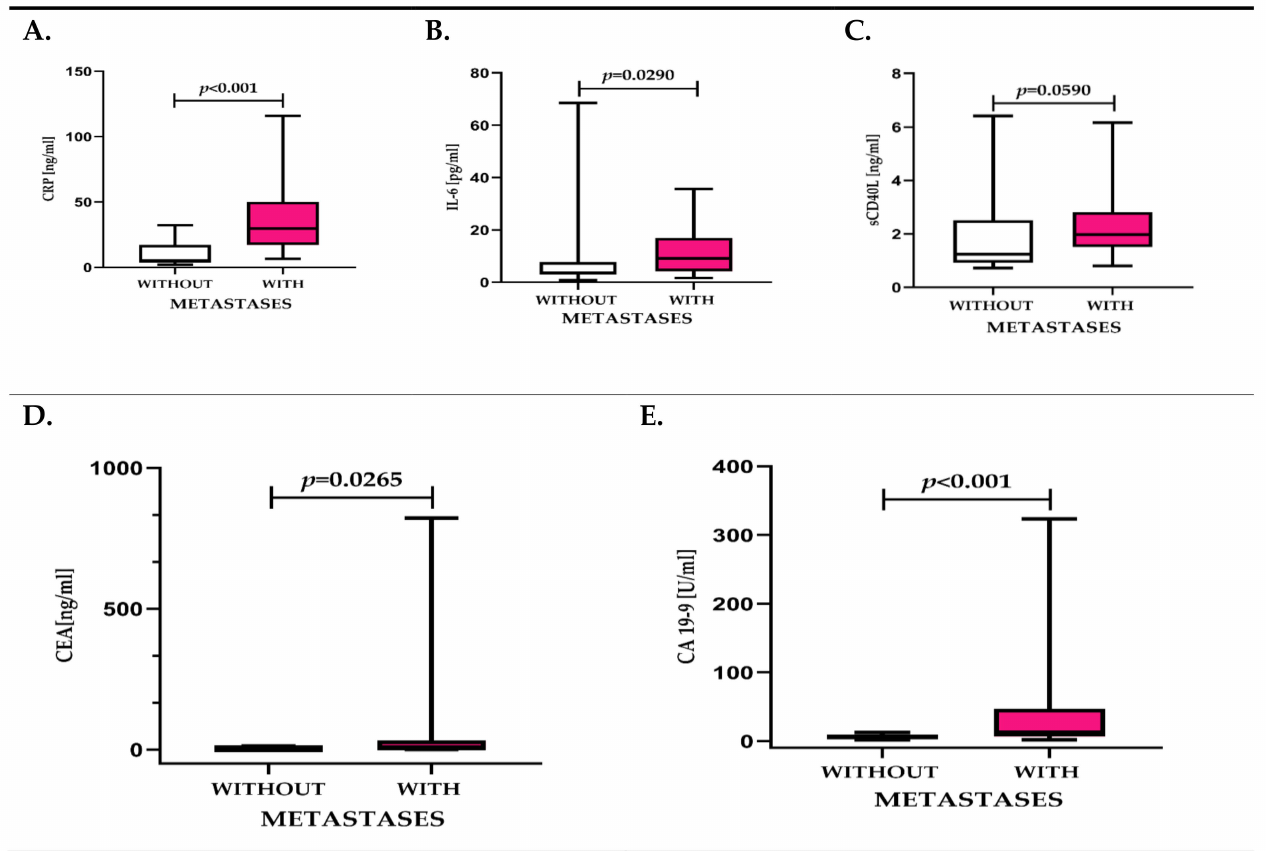
Figure 3. ( A – E ). Concentration of inflammatory response biomarkers (CRP, IL-6, sCD40L) and cancer biomarkers (CEA, CA 19-9) in colorectal cancer patients (CRC) depending on the presence of metastases.